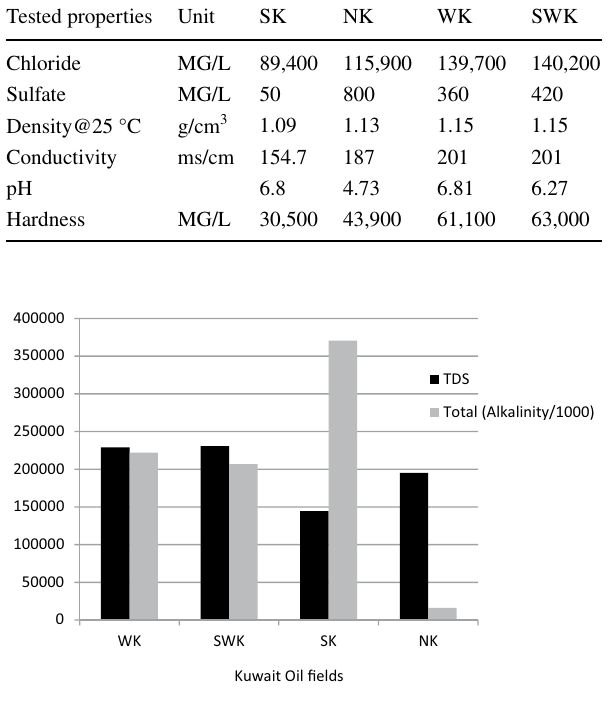
Fig. 1 Calculated TDS (MG/L) and total alkalinity (MG/L) for efflu- ent water from different oil